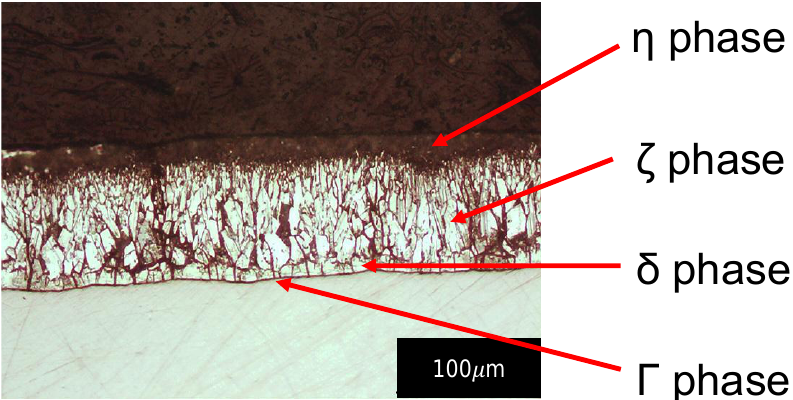
Figure 1. Hot dip galvanized coatings: typical intermetallic phases. The described phases characterize the galvanic layers given by pure zinc baths, but often, in the production industrial realities, different alloying elements are added to the galvanizing bath to improve the wettability and the fluidity [10–12]. More recent research has found that alloying elements, such as 10% aluminium, also increase corrosion resis- tance, most likely due to the creation of a very stable and protective corrosion product phase known as simonkolleite [13]. Both the speed of intermetallic phase growth and the characteristics of the phases can be altered by alloying elements. The alloying elements that are not able to modify the characteristics of the intermetallic phases typical of pure zinc bath coatings are generally added to improve the diffusion phenomena and the wettability of the bath. In the past, the main element used to improve hot dip galvanizing was lead, which ensured more robust production processes capable of generating coatings with fewer defects. This element acts on the formation of the external phase η which constitutes the surface of the coating [14–16]. However, today lead has been eliminated from the baths as cation of one or more elements capable of optimizing the hot dip galvanizing processes. production realities is